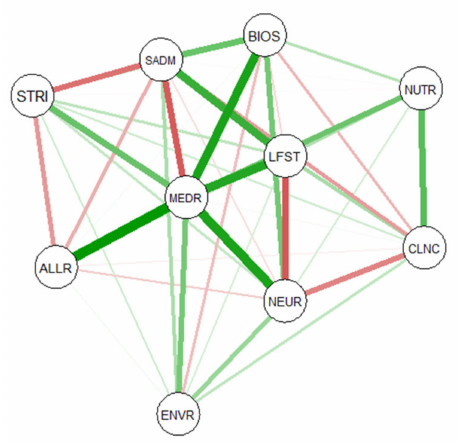
Figure 5. Results from a network analysis of key scientific areas and type of data collected. The size of the line represents the strength of the correlation between two factors. Green and red lines represent positive and negative correlations, respectively. STRI = Structured Interview; SADM = Self-administered data; BIOS = Biological samples; NUTR = Nutrition; LFST = Lifestyle; MEDR = Medical records; ALLR = Allergy; NEUR = Neurodevelopment; CLNC = Clinical assessment; ENVR=